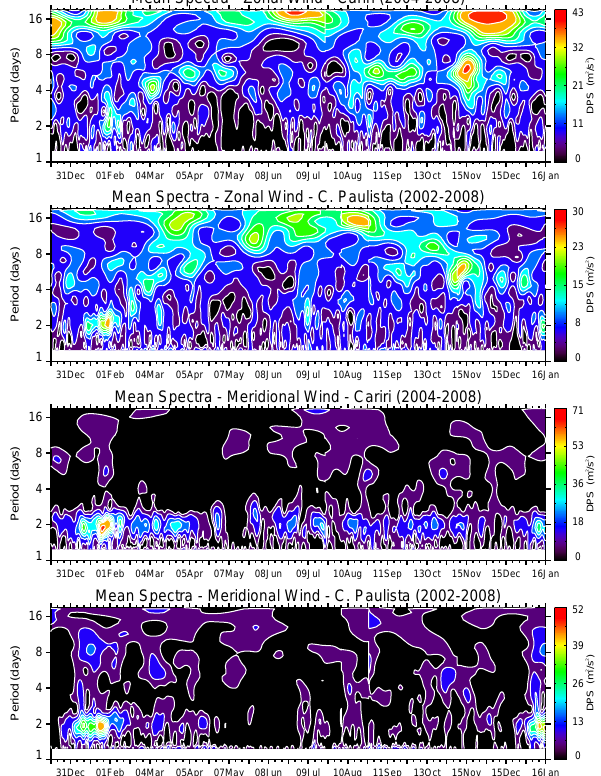
Figure 1. Annual averaged Morlet wavelet transform spectrum for Fig. 1. Annual averaged Morlet wavelet transform spectrum for zonal and meridional winds at 90 km over Cariri for the years 2004 to 2008 zonal and meridional winds at 90km over Cariri for the years 2004 and C. Paulista for the years 2002 to 2008 to 2008 and C. Paulista for the years 2002 to